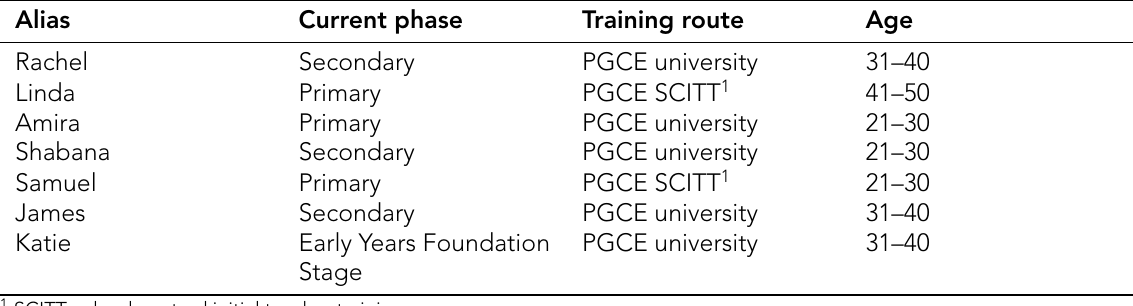
Table 2. Participants with age phase, training route and age bracket (Source: Authors, 2022)